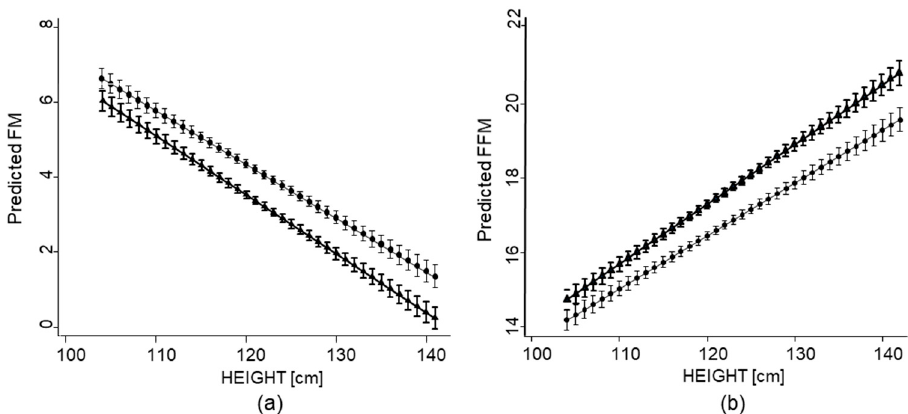
Figure 2. Association of height with body composition estimates by sex of school-aged children in the South African arm of the KaziAfya project: ( a ) FM; ( b ) FFM. Boy ; girl .